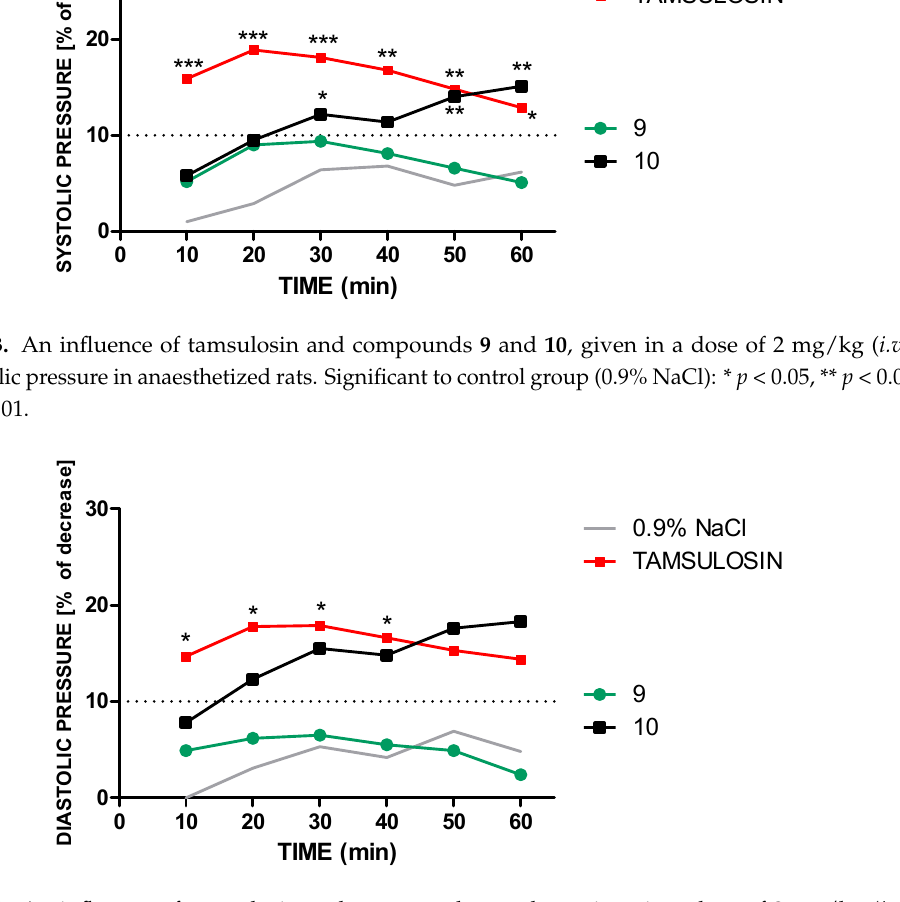
Figure 4. An influence of tamsulosin and compounds 9 and 10 , given in a dose of 2 mg/kg ( i.v. ), on diastolic pressure in anaesthetized rats. Significant to control group (0.9% NaCl): * p < 0.05.